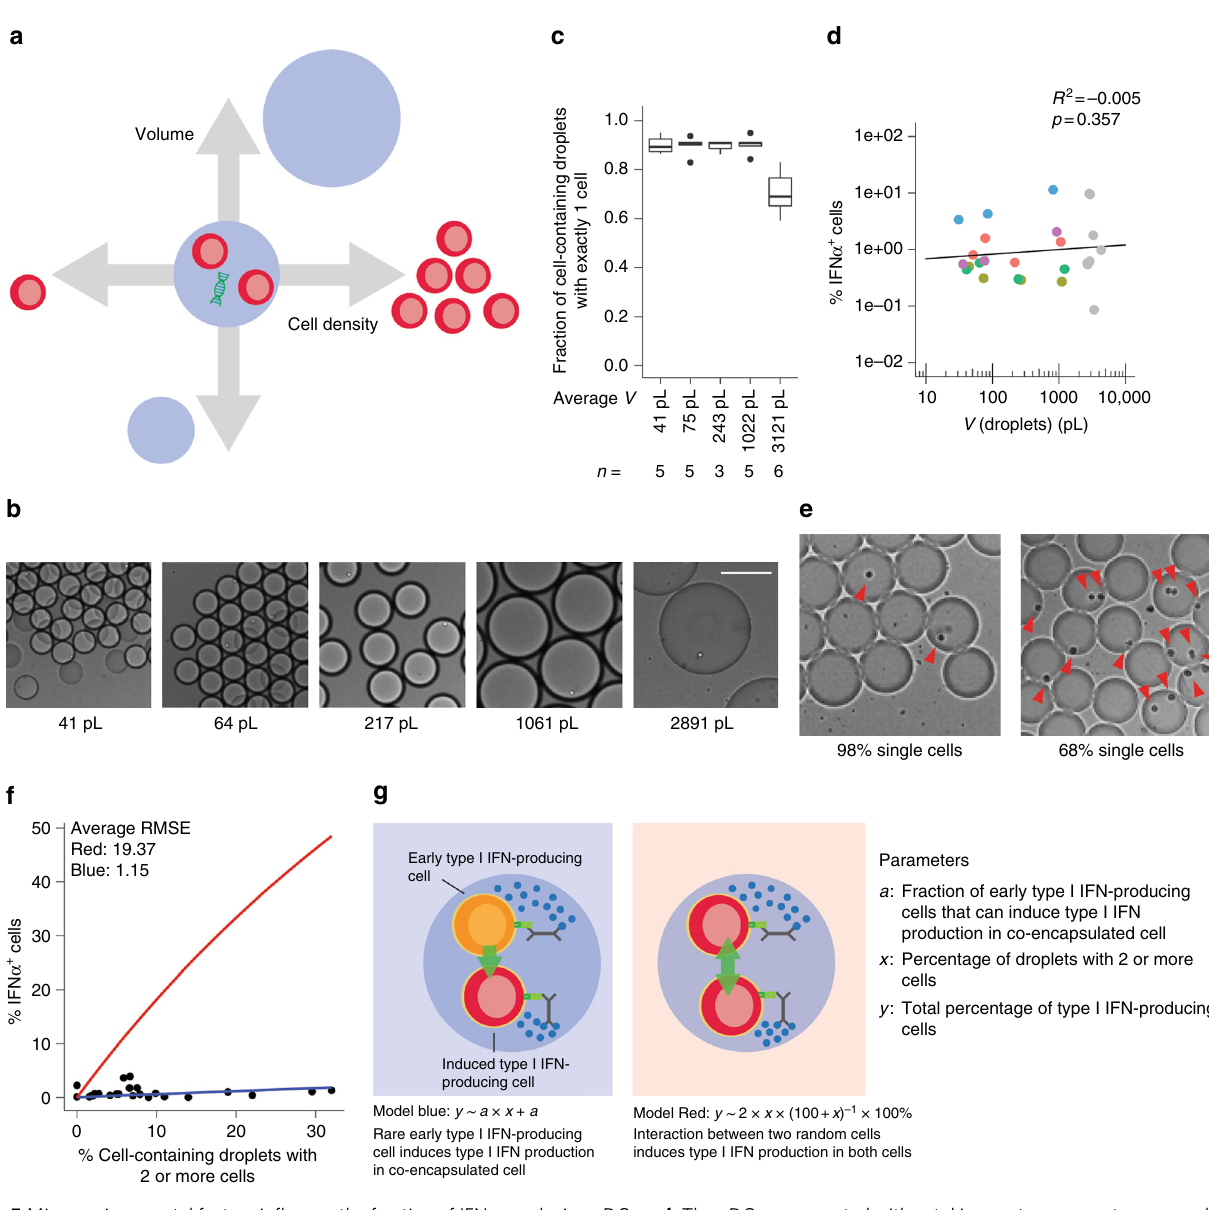
Fig. 5 Microenvironmental factors in fl uence the fraction of IFN α -producing pDCs. a , b The pDCs were coated with cytokine capture reagents, encapsulated in droplets of varying size ( b , scale bar equals 100 µ m), and stimulated individually with 50 µ g/mL CpG-C for 12 h. The distribution of cells in droplets was measured by manual analysis of microscopic images after production. After staining for viability and surface marker expression, viable cells and TNF α - positive cells were detected via fl ow cytometry. c Shown is the fraction of cell-containing droplets with exactly one cell; n > = 3. Lines indicate mean, hinges mark interquartile ranges, and whiskers reach to the highest/lowest value that is within 1.5 × interquartile range. d The fraction of IFN α -secreting pDCs was plotted against droplet volume. Dots of the same color indicate cells from the same donor. Gray dots are all originating from different donors. Linear regression was employed to calculate a trend line; n = 24. a , e The pDCs were stimulated in ~92 pL droplets with an increasing fraction of droplets containing more than 1 cell. f Shown is the fraction of IFN α -secreting cells plotted against the fraction of droplets containing more than 1 cell. Two models were generated to explain the observed pattern: (red) two random pDCs co-encapsulated in the same droplet can induce type I IFN production in each other; (blue) rare early type I IFN-producing cells can induce type I IFN production in conventional co-encapsulated cells. The root-square-mean error (RMSE) was calculated for both models to compare the fi t to the data; n = 24. g Schematic overview of both